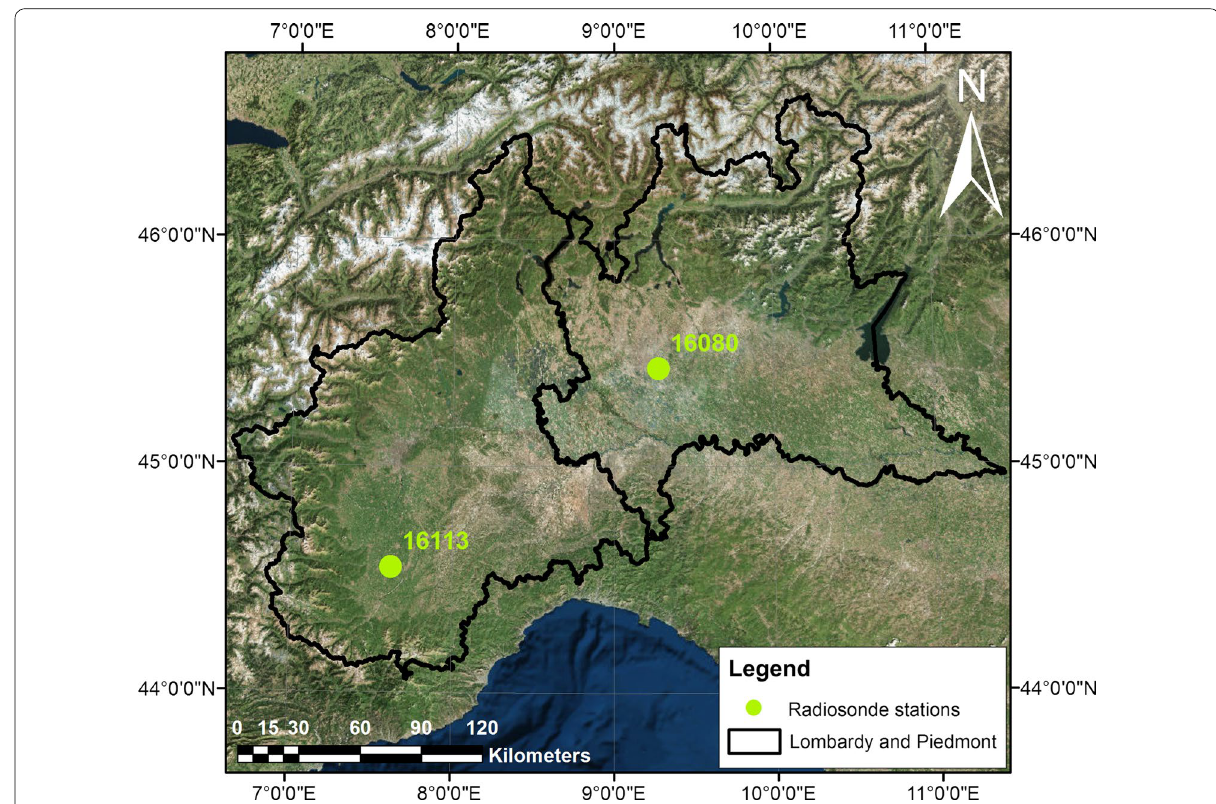
Fig. 3 Radiosonde stations in the analyzed area. WMO id 16113: Cuneo Levaldigi station; WMO id 16080: Milano Linate